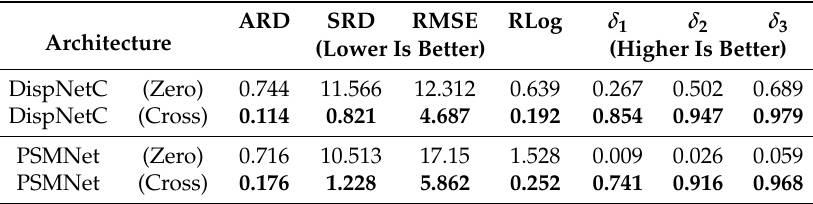
Table 1. Comparison between different input schemes